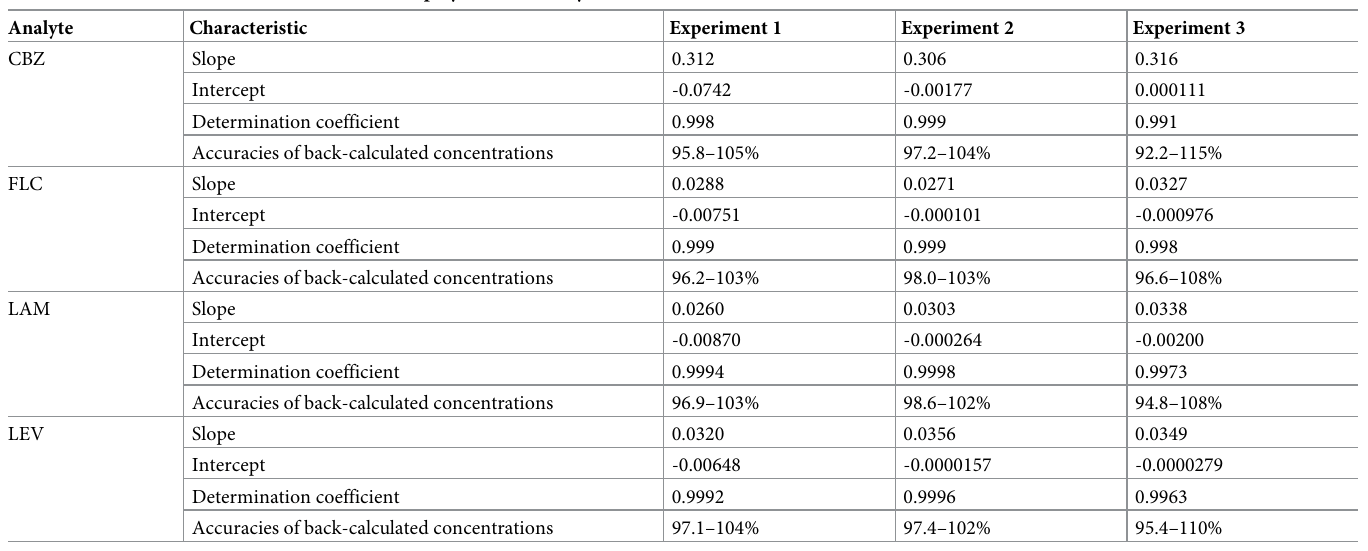
Table 2. Performance of the calibration curves employed in this